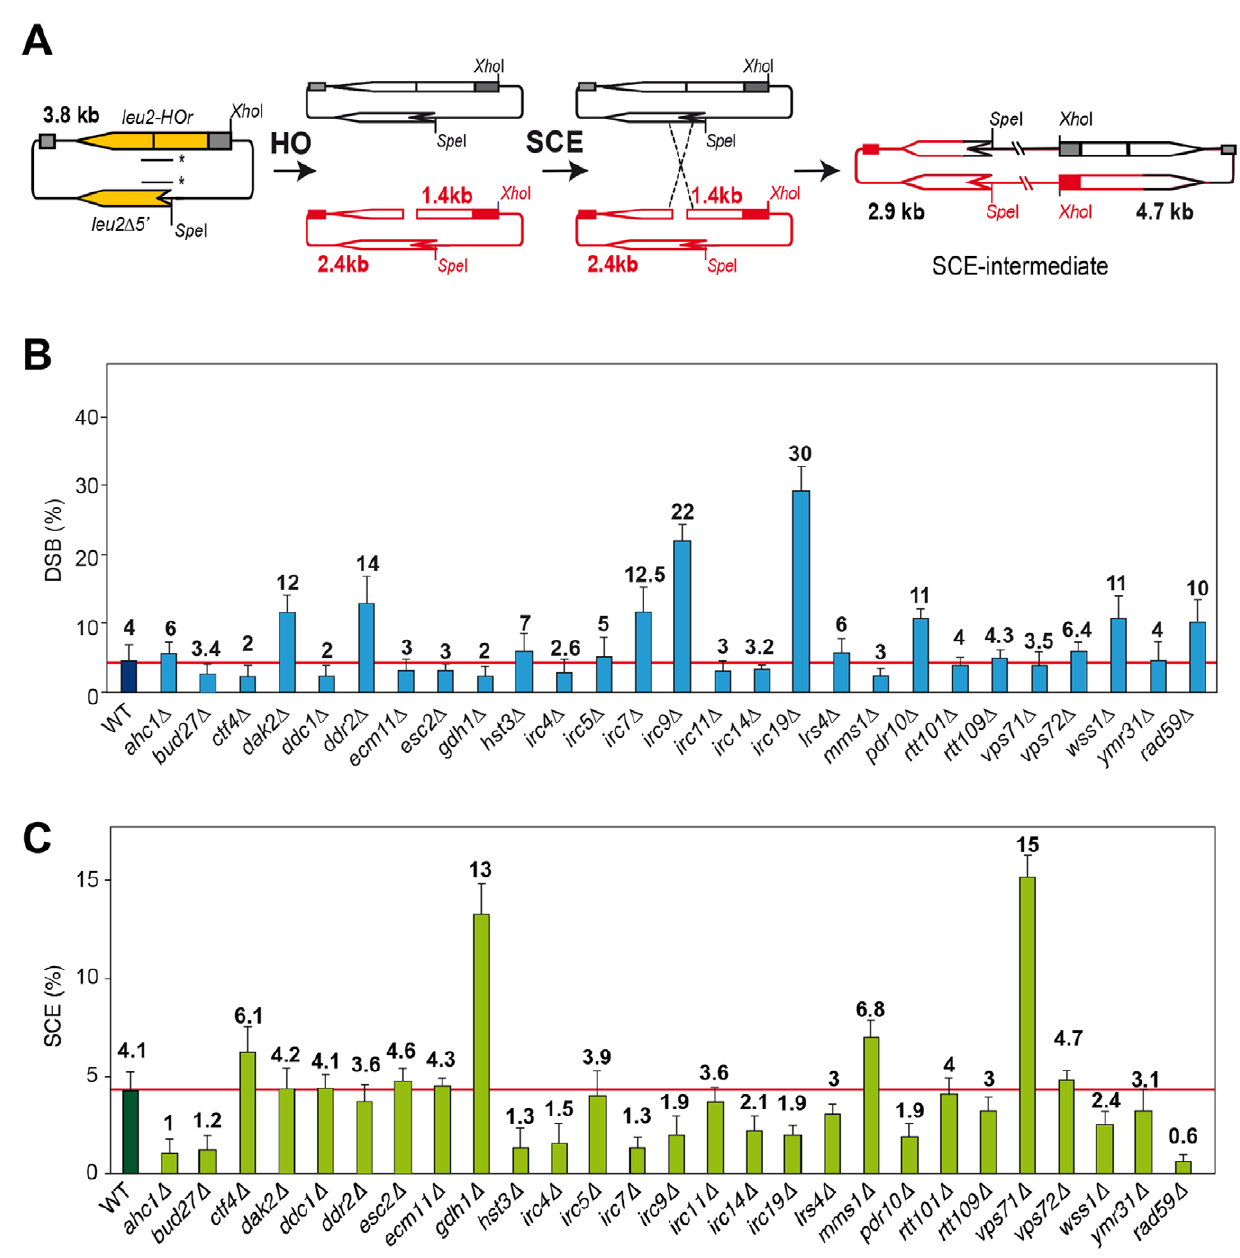
Figure 1. Molecular analysis of SCR in 27 hyper-recombination mutants. (A) Scheme of plasmid pRS316TINV used for the physical monitoring of SCR of a replication-born DSB. Fragments generated after Xho I- Spe I digestion, detected with a LEU2 probe (line with asterisks) are indicated with their corresponding sizes. SCR is monitored by appearance of the 4.7-kb fragment, the only one unequivocally occurring via SCR. (B) Quantification of DSB 2.4- and 1.4-kb fragments after 6 hours of HO activation in galactose. (C) Quantification of the SCR 4.7-kb fragment after 6 hours of HO activation in galactose. All strains, isogenic to W303, were transformed with pRS413GALHO harboring the HO endonuclease gene under the control of the GAL10 promoter, and pRS316TINV. Average and standard deviations of three samples from each genotype are plotted. Additional results are shown in Figures S1, S2, S3.